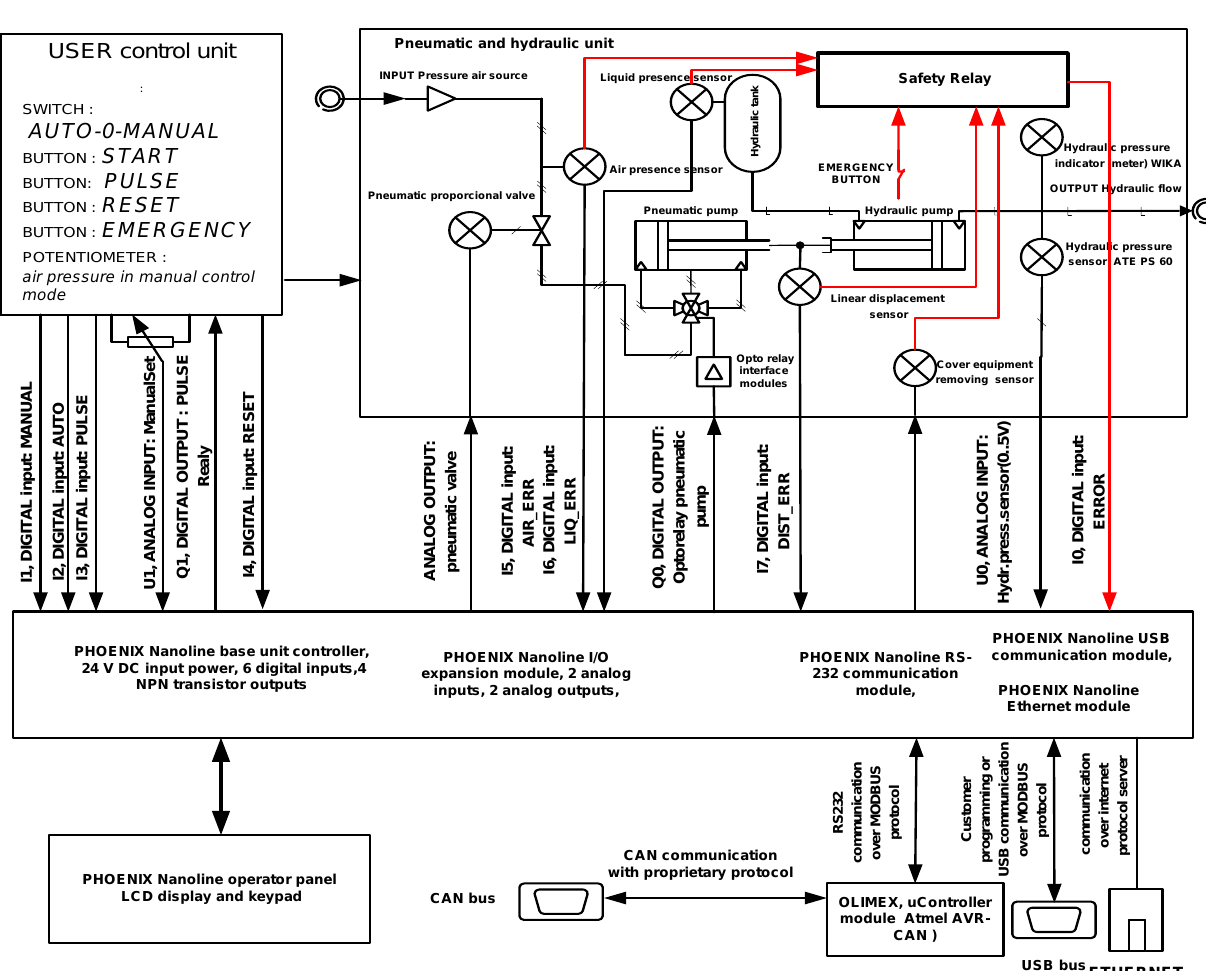
Figure 2. Schematic diagram of the developed pneumatic – hydraulic system.